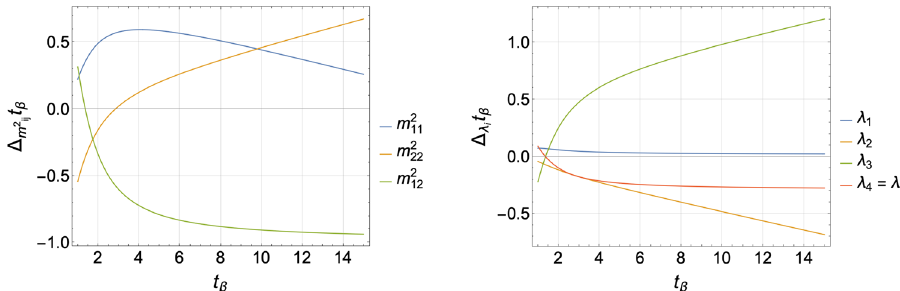
Fig. 15 The same as Fig. 9 for Scenario